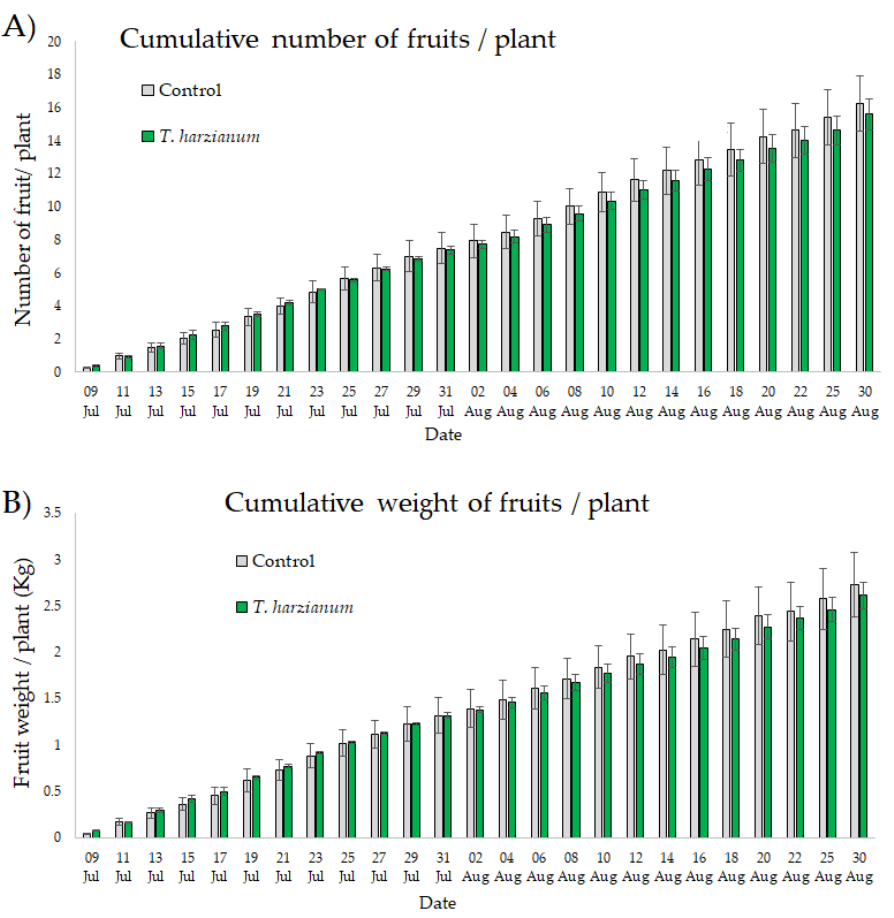
Figure 11. Mean values (± standard errors) of the cumulative number ( A ) and weight of zucchini fruits ( B ) recorded after each harvest from 9 July to 30 August from plants inoculated with T. harzianum T22 and from control.